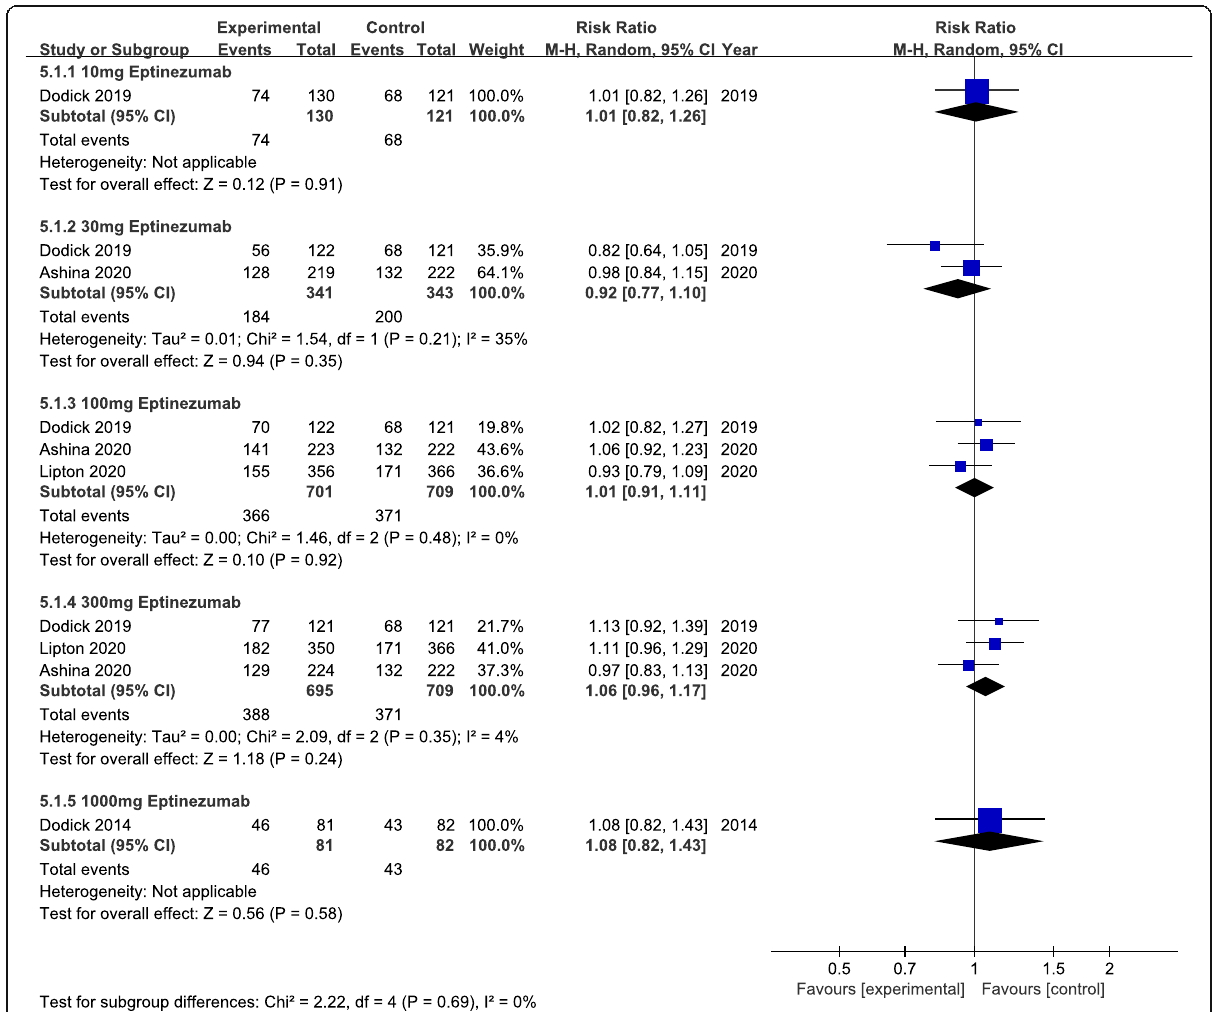
Fig. 6 The pooled risk ratio (RR) of patients with treatment emergent adverse events (TEAEs) in different treatment doses compared with placebo, the diamond indicates the estimated RR with 95% confidence interval (CI) for the pooled